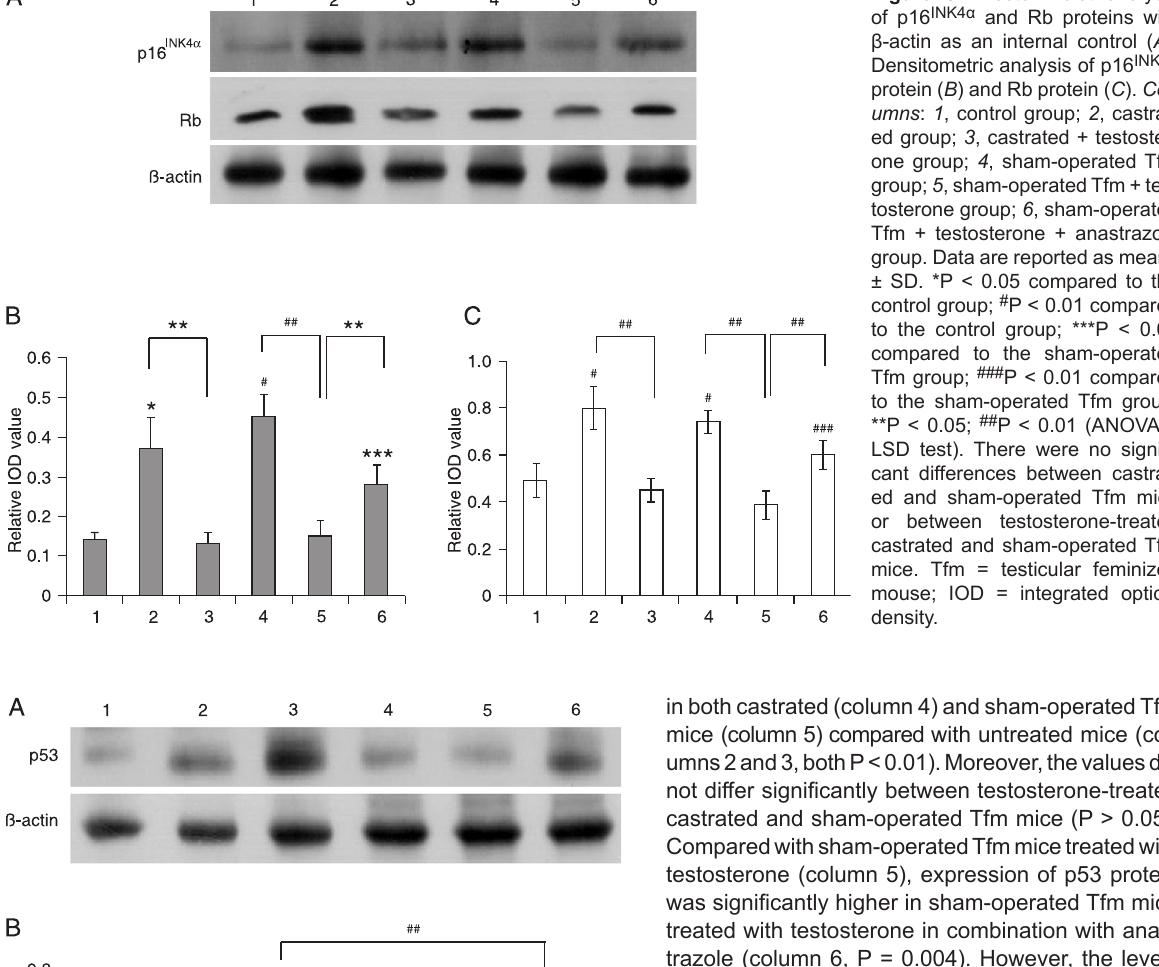
Figure 3. Western blot analysis of p16 INK4α and Rb proteins with β-actin as an internal control ( A ). Densitometric analysis of p16 INK4α protein ( B ) and Rb protein ( C ). Col- umns : 1 , control group; 2 , castrat- ed group; 3 , castrated + testoster- one group; 4 , sham-operated Tfm group; 5 , sham-operated Tfm + tes- tosterone group; 6 , sham-operated Tfm + testosterone + anastrazole group. Data are reported as means